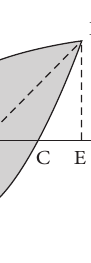
Figure 20: Relationships between P